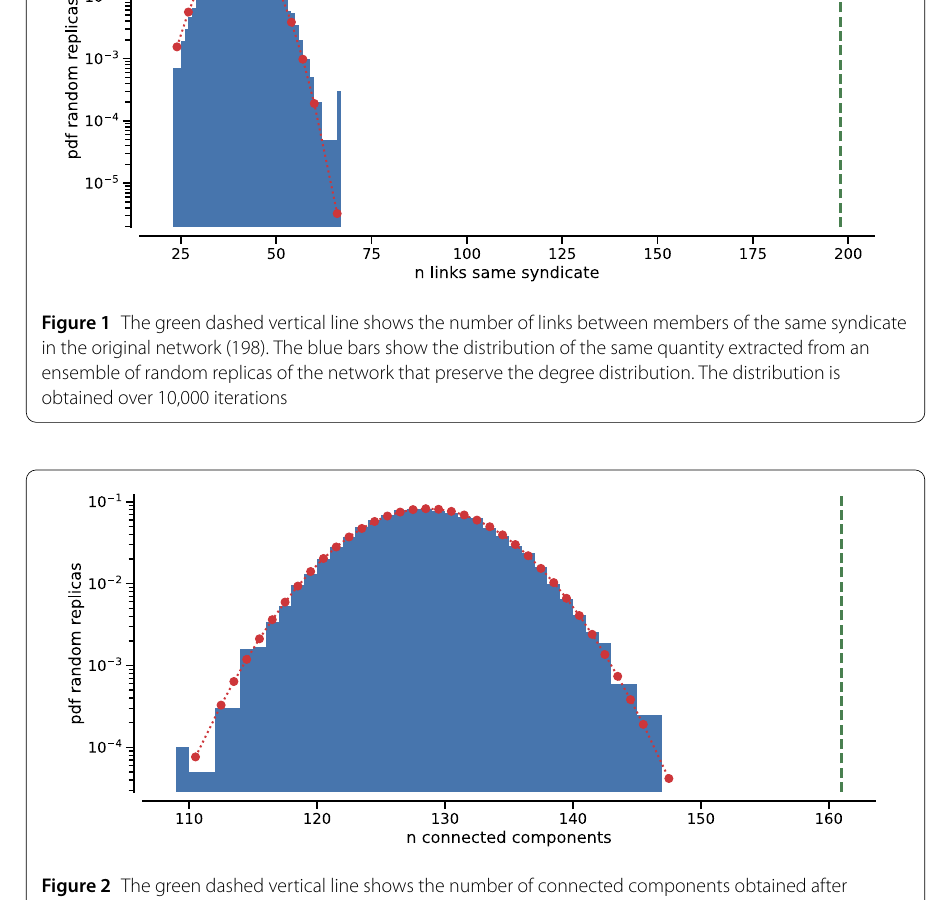
Figure 2 The green dashed vertical line shows the number of connected components obtained after removing links between affiliates to different mafia syndicates in the original network. The blue bars show the the distribution of the same quantity obtained removing the same number of randomly selected links. The distribution is obtained over 10,000